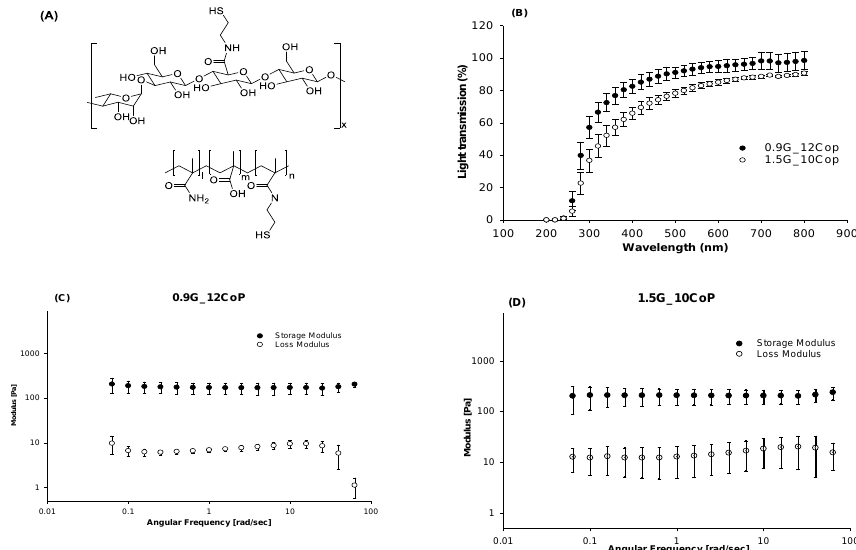
Figure 2. ( A ) Chemical structure of thiolated gellan and poly(MAM-co-MAA-co-BMAC); ( B ) Optical transmittance of hydrogel formulations between 200 to 800 nm; ( C ) Storage and loss moduli of 0.9G_12Cop formulation; ( D ) Storage and loss moduli of 1.5G_10Cop formulation.